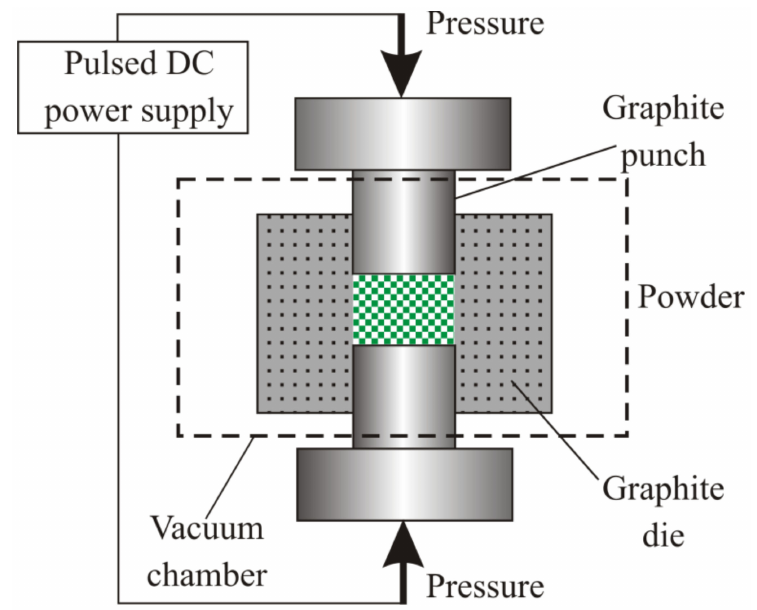
Figure 3. Schematic view of SPS